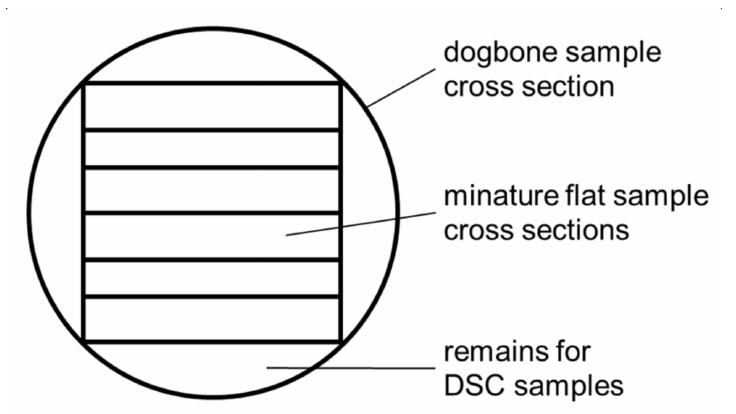
Figure 3. Differential scanning calorimetry (DSC) samples stemming from remains of the cylindrical dogbone samples after electro-discharge machining (EDM) cutting of the miniature flat samples.